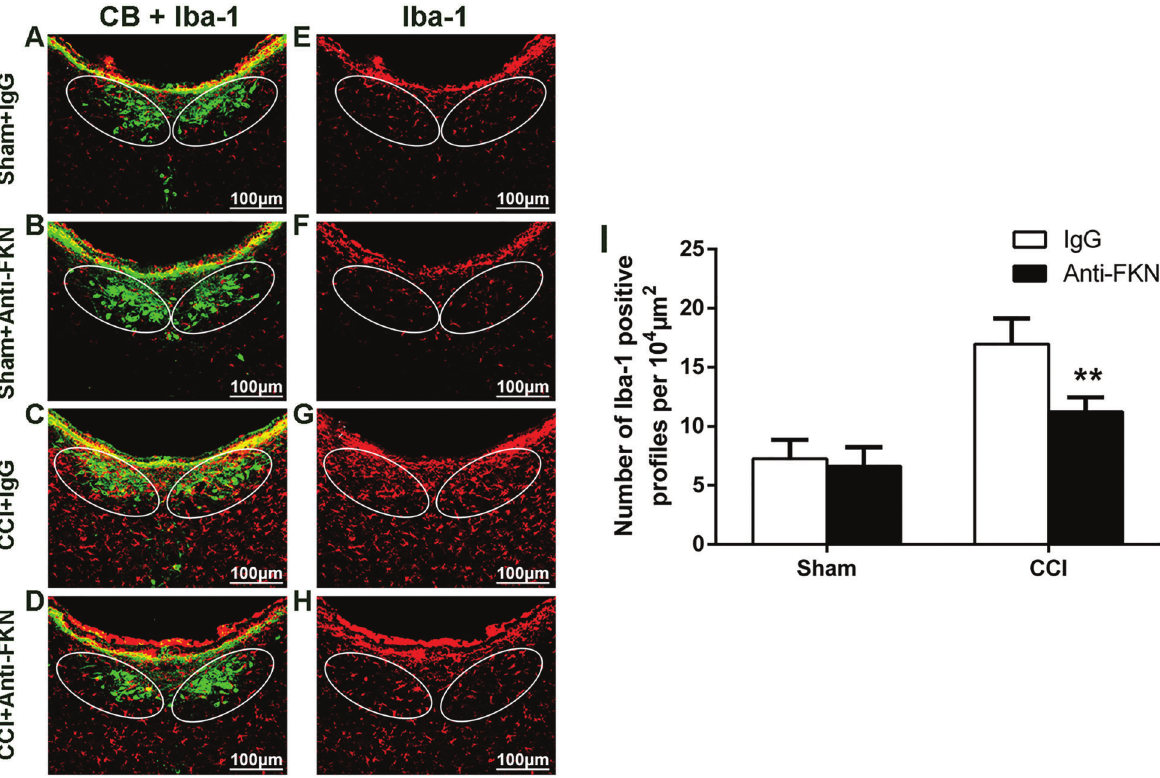
Figure 6. Fractalkine (FKN)-neutralizing antibody attenuated the microglial response following chronic constriction injury (CCI). CB-labeled neurons (green in A - D ) were used to locate the CSF-contacting nucleus. The cells testing positive for Iba-1 (red in E - H ) within the box in the areas to the left and the right of CSF-contacting nucleus were counted. I , Quanti fi cation of Iba-1 immunoreactivity. **P o 0.01 vs the CCI + IgG group, n=5 per group, F=240.048 (two-way ANOVA, LSD test). Scale bar =100 m m. CSF: cerebrospinal fl